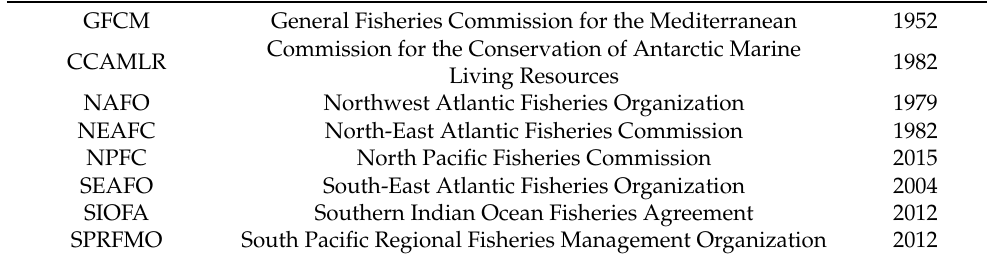
Table 2. General RFMOs.